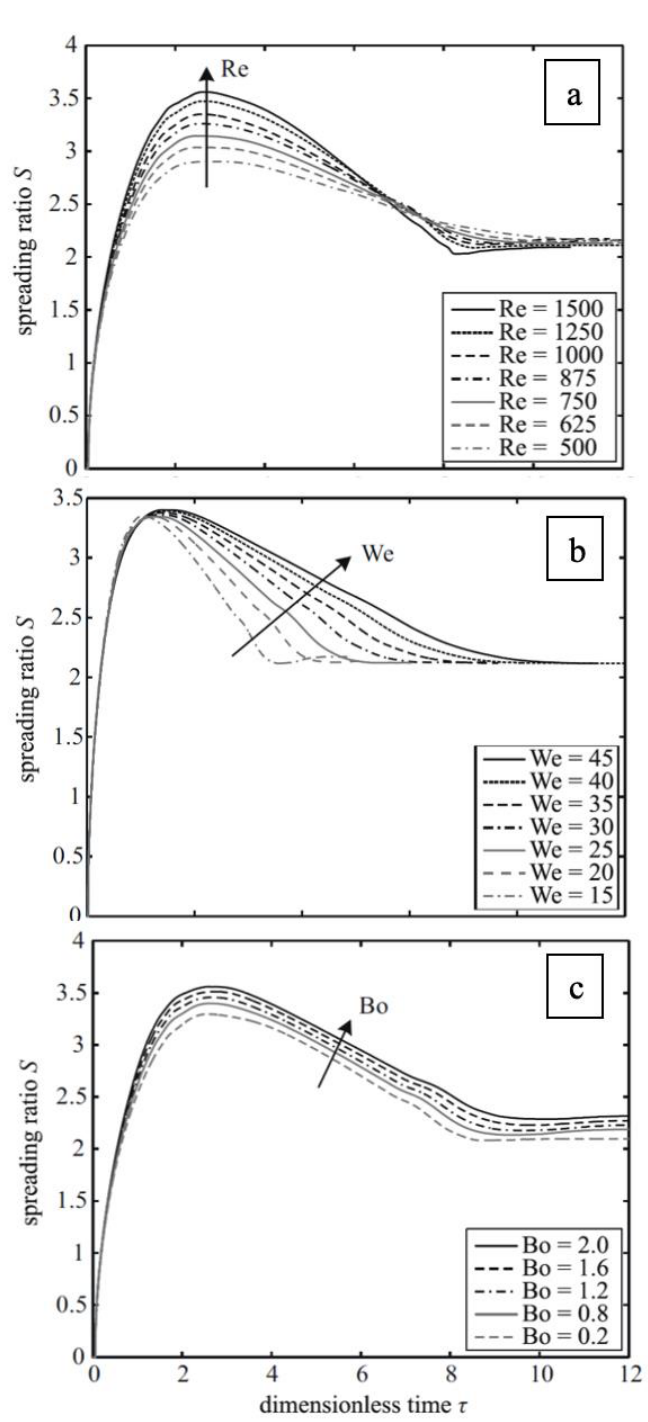
Figure 8. Effect of dimensionless numbers on the droplet spreading ratio; ( a ) effect of the Reynolds number ( We = 15, Bo = 0.5, Pr = 9.54), ( b ) effect of the Weber number ( Re = 1000, Bo = 0.5, Pr = 9.54), and ( c ) effect of the Bond number ( We = 15, Re = 1000, Pr = 9.54; reproduced with permission from [60]).